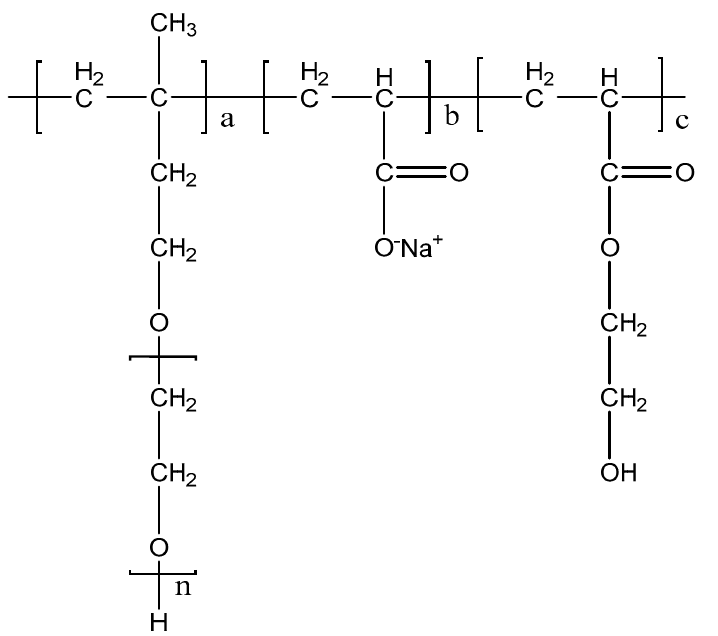
Figure 2. Molecular formula of sustained-release polycarboxylic acid superplasticizer H.